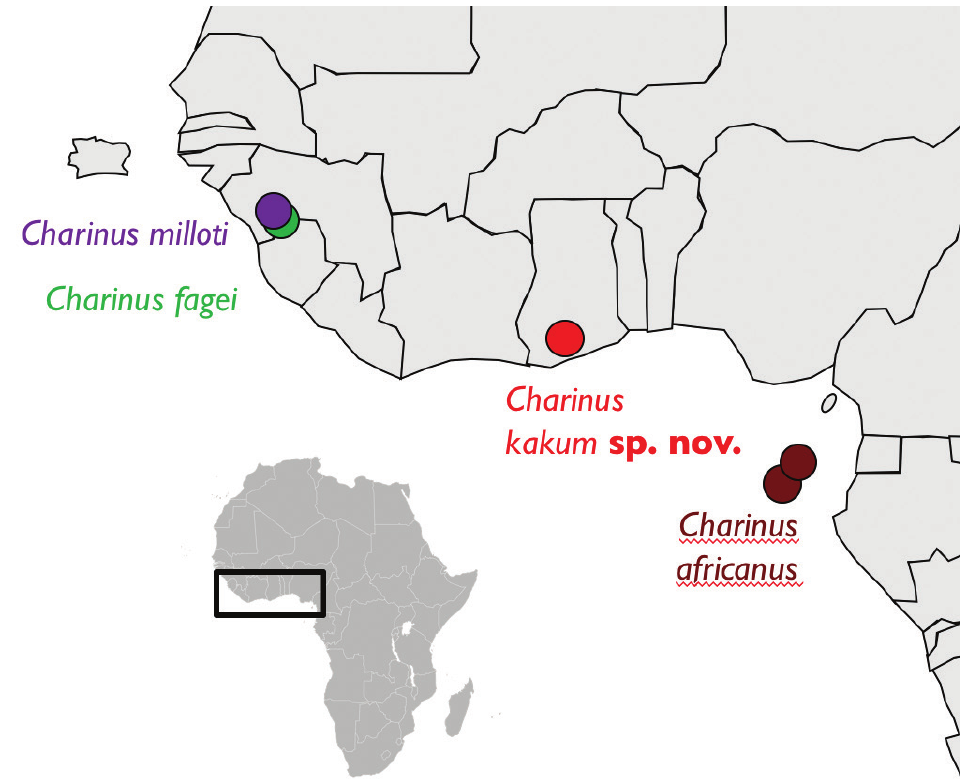
Figure 1. Distribution map showing the type localities of the described species of Charinus in West Africa according to Harvey (2013). The type locality of Charinus kakum sp. n. is highlighted in red. Note that the localities for Charinus milloti and C. fagei may contain some error because both species were originally described from caves with an unknown location. The symbols indicate the regions in which the caves may be